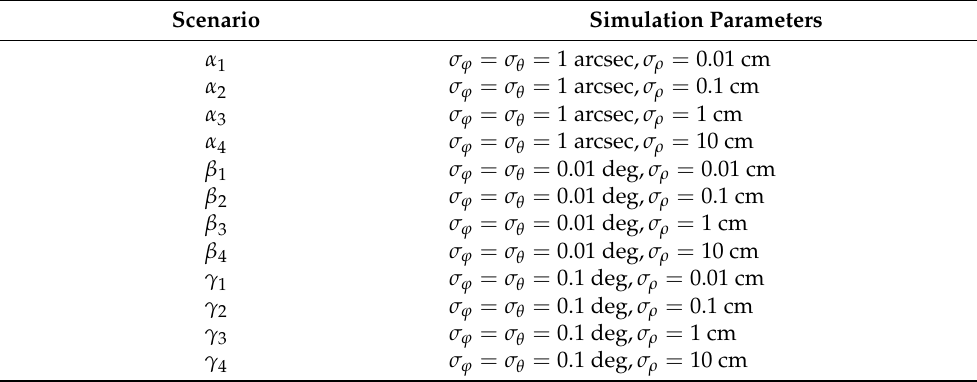
Table 5. Simulation scenarios and simulation